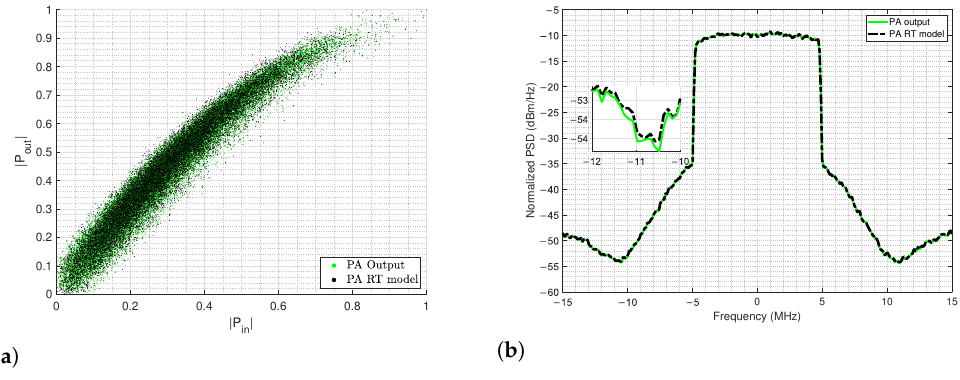
Figure 14. Modeling extraction and evaluation for the; ( a ) Construction process of the AM-AM PA model with RT and ( b ) PSD of the output PA spectral regrowth with RT model basis.